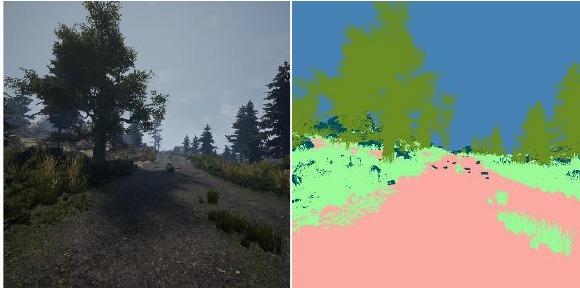
Figure 5. Original image and its segmentation